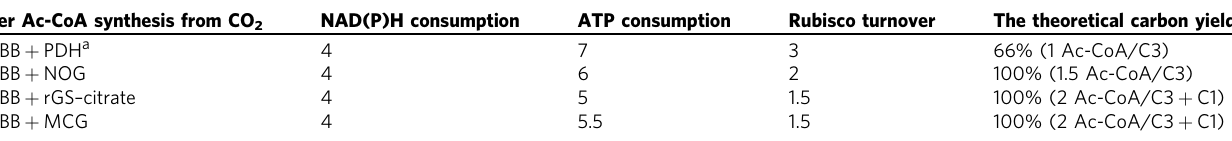
Table 1 Comparison of different pathway combinations for synthesizing each acetyl-CoA from CO 2 equivalents Per Ac-CoA synthesis from CO